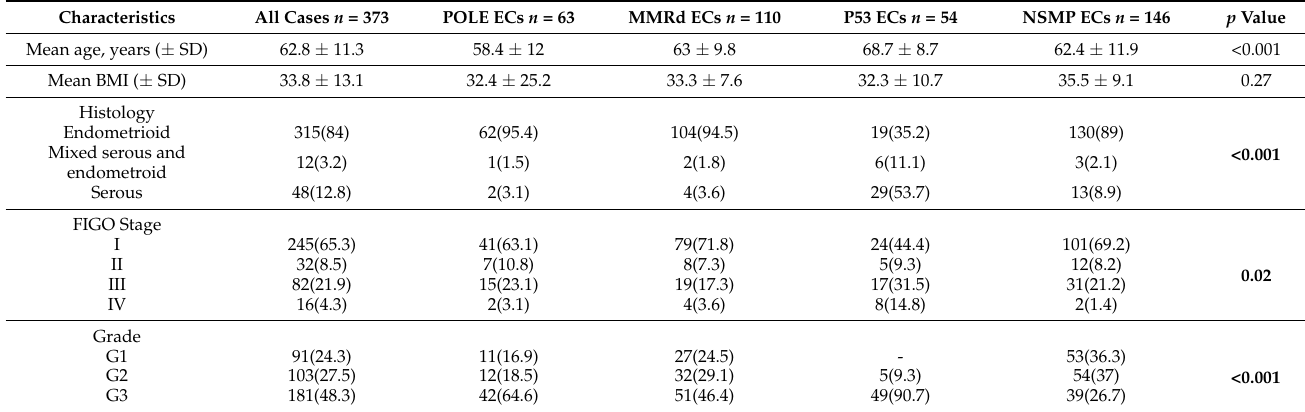
Table 6. TCGA study cohort: patient and pathologic characteristics of EC according to TCGA